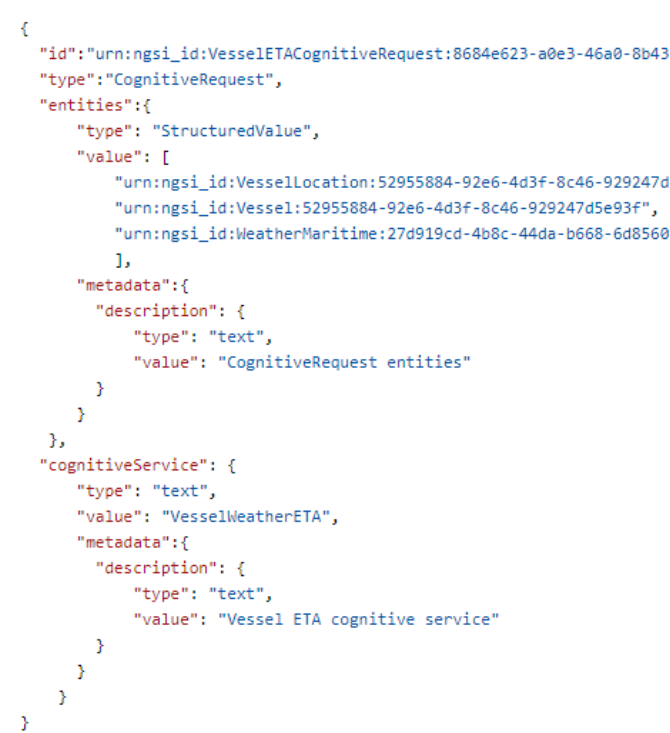
Figure A1. Cognitive Request message.